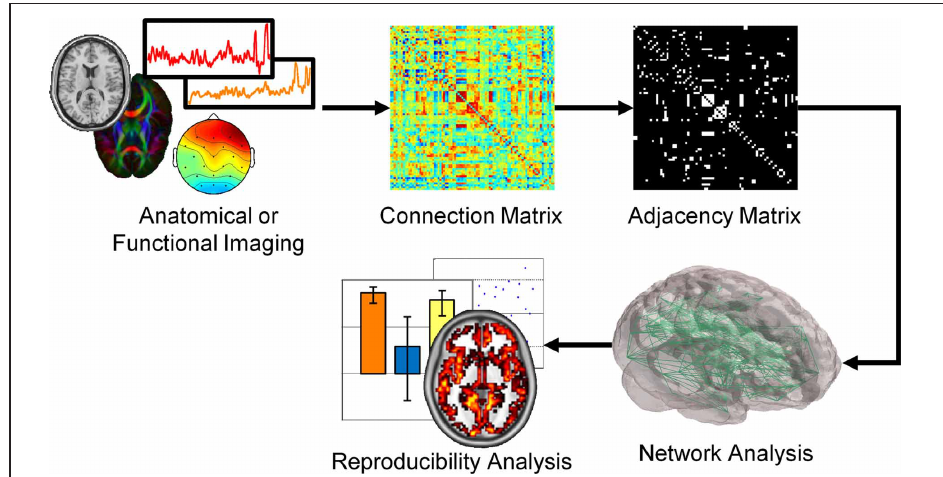
FIGURE 1 | Schematic of brain network construction and graph metric analysis. Anatomic or functional data is analyzed to generate a connection matrix, denoting the strength or number of connections between nodes. A threshold is commonly applied to the connection matrix to produce a binary adjacency matrix. From this adjacency matrix, various graph metrics, and statistical analyses can be assessed from these